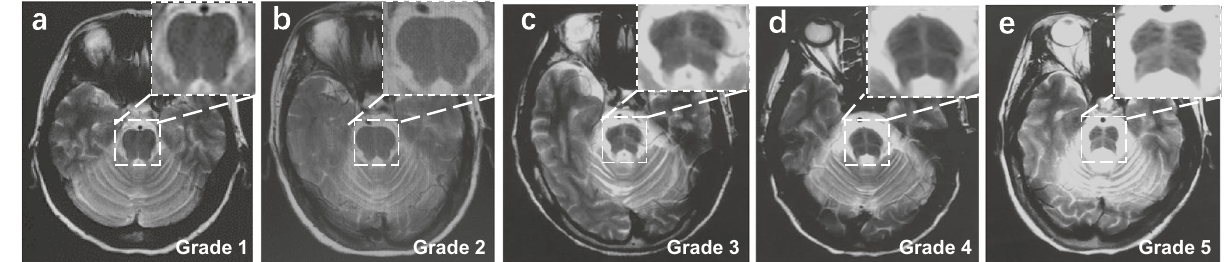
Fig. 3 Representative imaging of MSA patients with HCBs. a – e Pontine “ cross sign ” stages 1 – 5. a Stage 1 at an emerging vertical T2 high signal line. b Stage 2 where the clear vertical line appeared. c Stage 3 where the horizontal line emerged. d Stage 4 where the horizontal line appeared as well as the vertical line completed ( “ cross ” line completed). e Stage 5 where clear cross bun sign accompanied with pontine base atrophy.